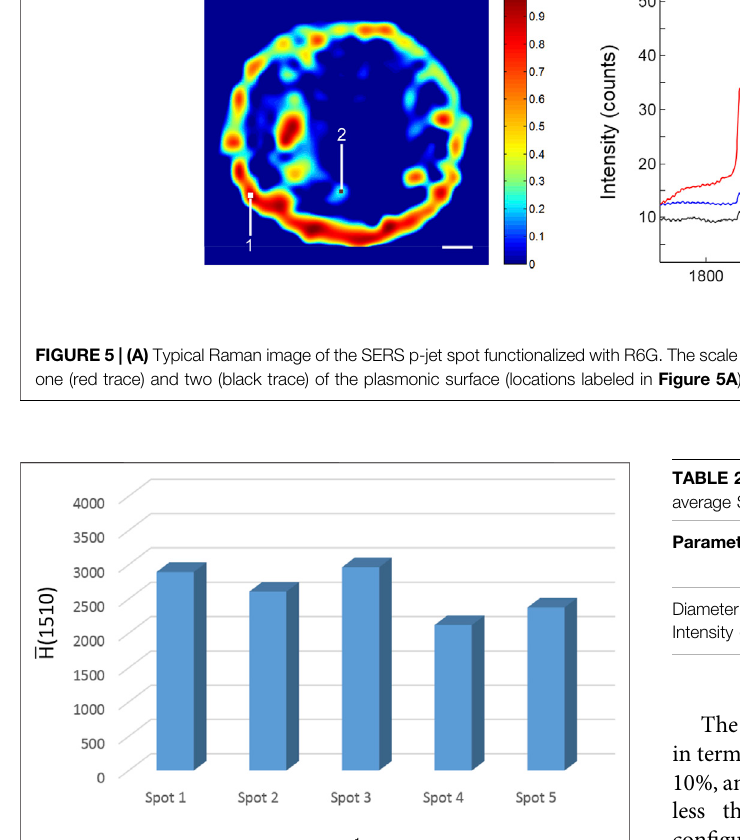
FIGURE 6 | The intensity of the 1,510-cm − 1 peak of R6G evaluated on the SERS spectrum averaged over the whole sensing area. The (cid:1) H ( 1510 ) value has been determined on fi ve distinct SERS spots.